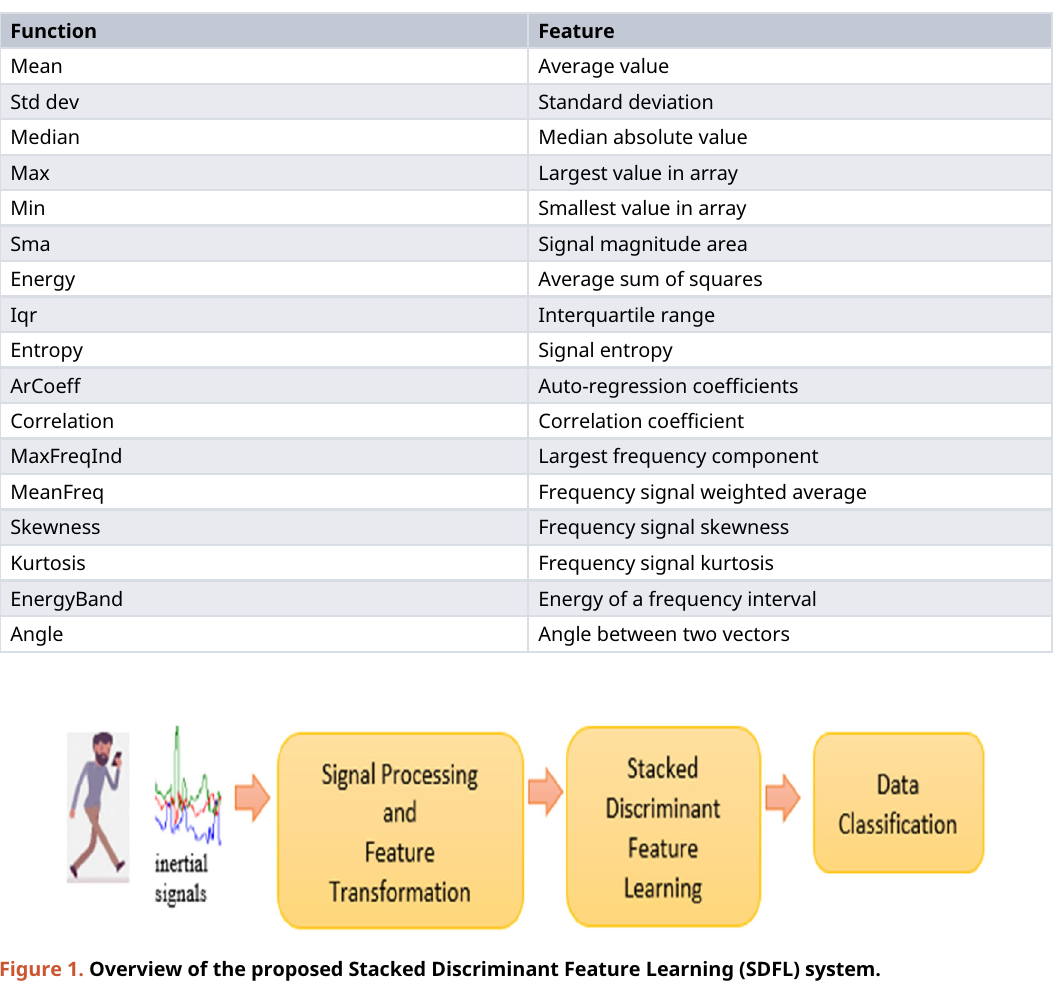
Table 1. Pre-processed features as input data into the Stacked Discriminant Feature Learning (SDFL) system.